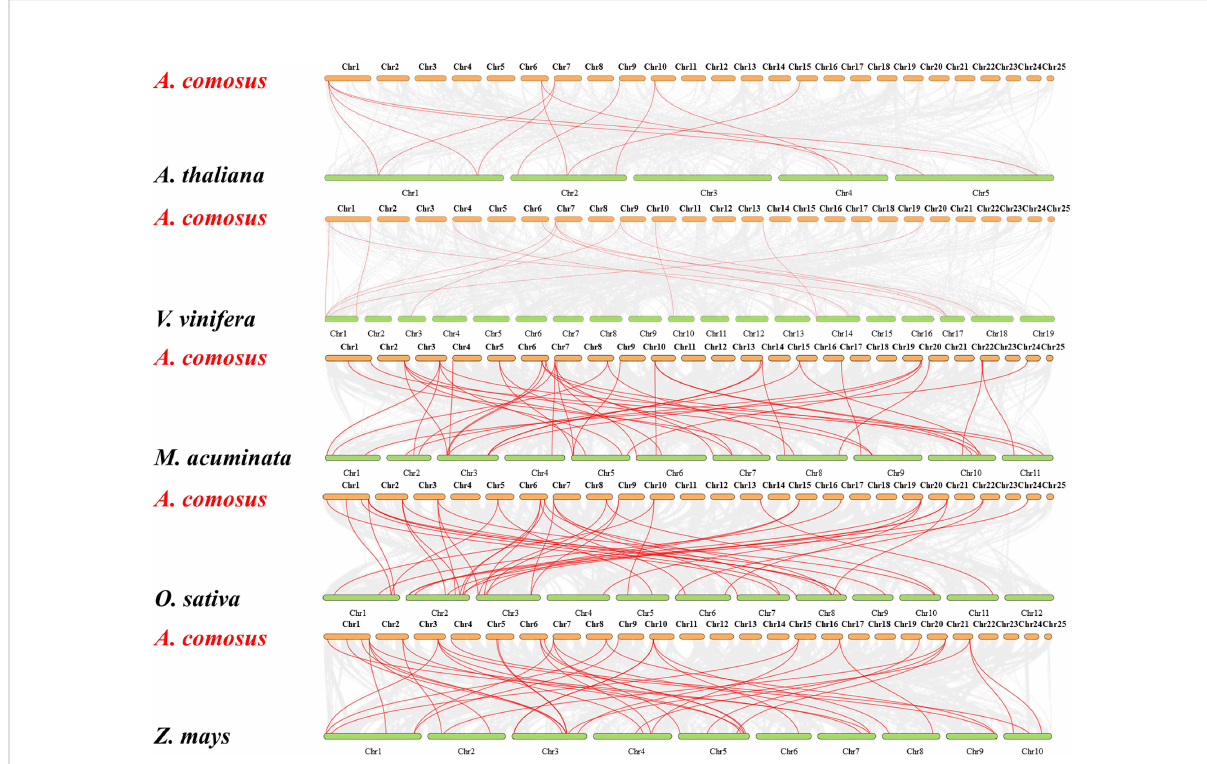
FIGURE 5 Syntenic analysis of MADS-box genes between pineapple and other fi ve species. The gray lines represent the collinear blocks between pineapple and other plant genomes. The red lines indicate the collinear blocks of the pineapple MADS genes. Species names: A. comosus: Ananas comosus